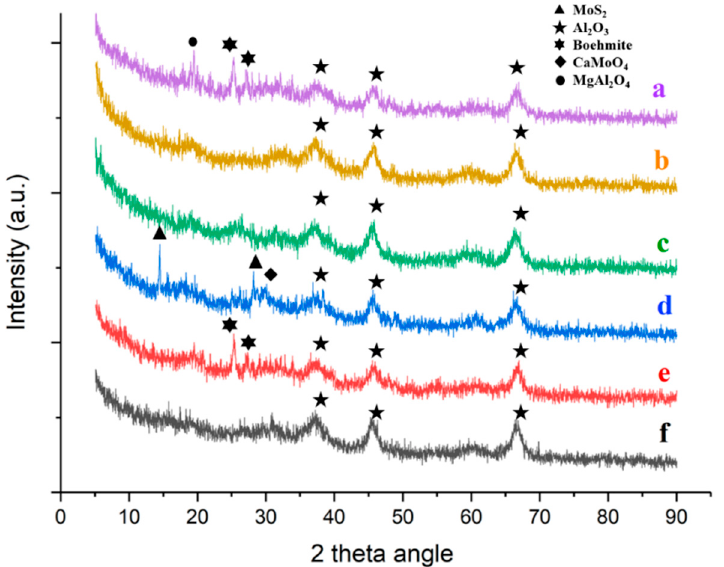
Figure 8. XRD patterns of CATs deactivated for different reasons ( a ) Cl; ( b ) As; ( c ) caking 1; ( d ) caking 2; ( e ) steam-soaked; ( f ) as-prepared.